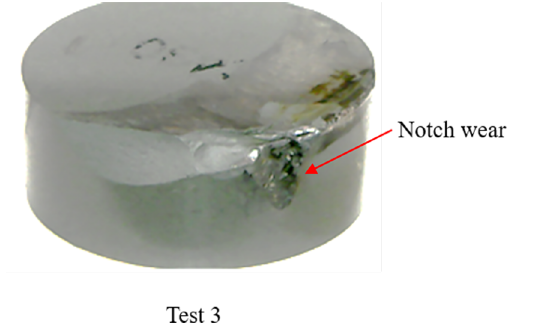
Figure 2. Catastrophic failure of whisker-reinforced